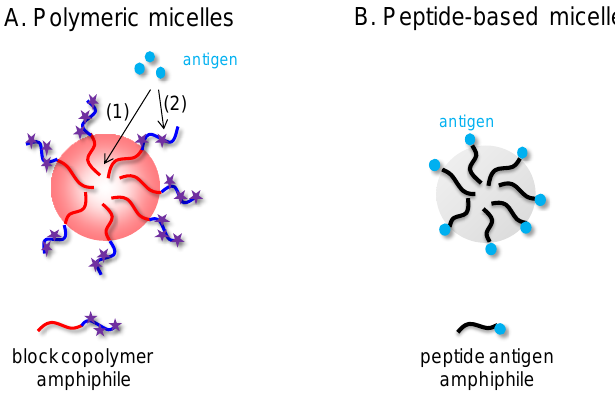
Figure 1. Schematical representation of the micellar nanoparticles developed as vaccine adjuvants; ( A ) polymeric micelles obtained by self-assembly of amphiphilic block copolymers in water, in/on which the antigenic peptide is encapsulated (1) or surface coupled (2) (reactive groups represented by star symbols); ( B ) micelles obtained from self-assembly of peptide antigen amphiphiles in